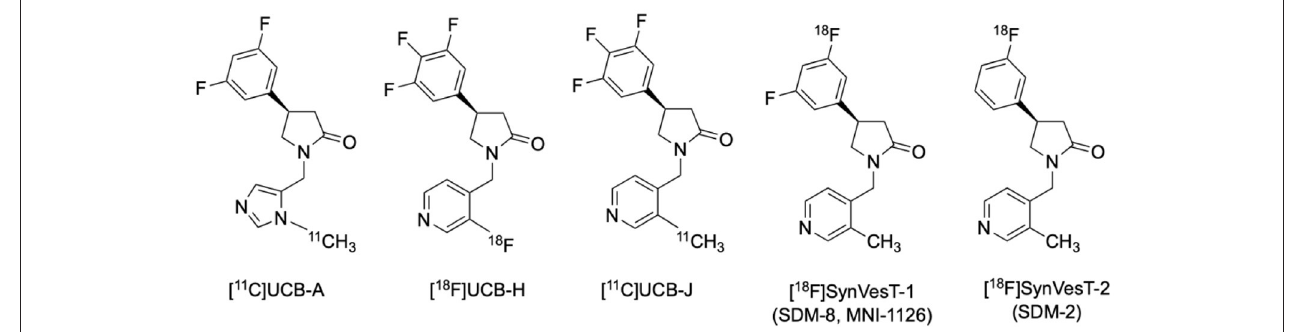
FIGURE 8 | Structures of representative PET radiotracers for SV2A.